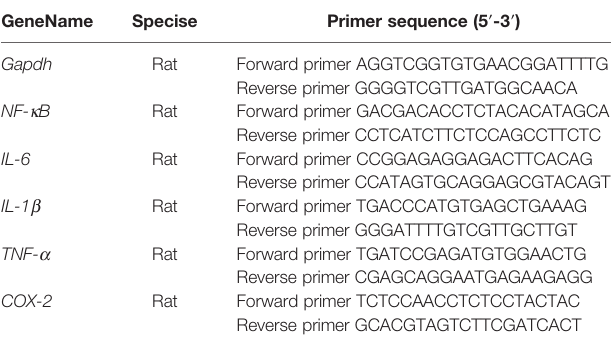
TABLE 2 | Primers of real-time PCR assay used in this